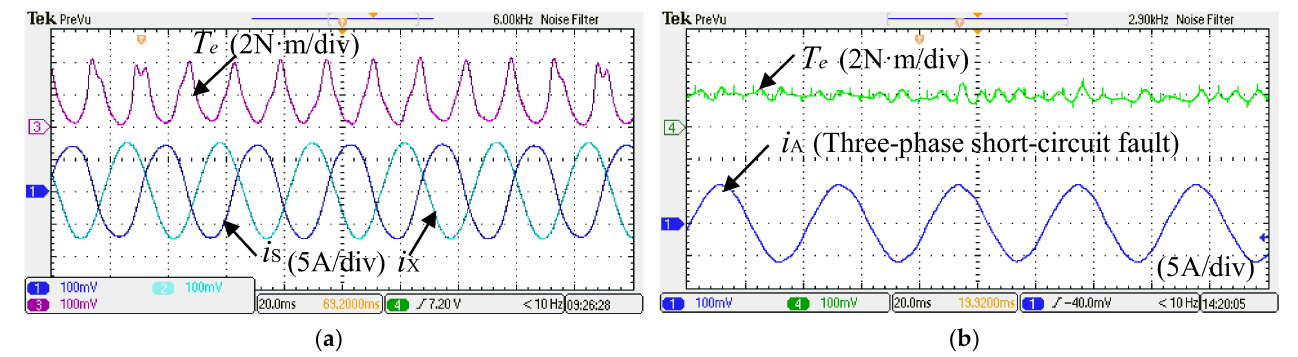
Figure 18. Output torque and phase current waveform under healthy condition.